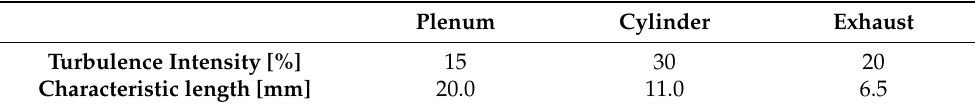
Table 2. Initial turbulent